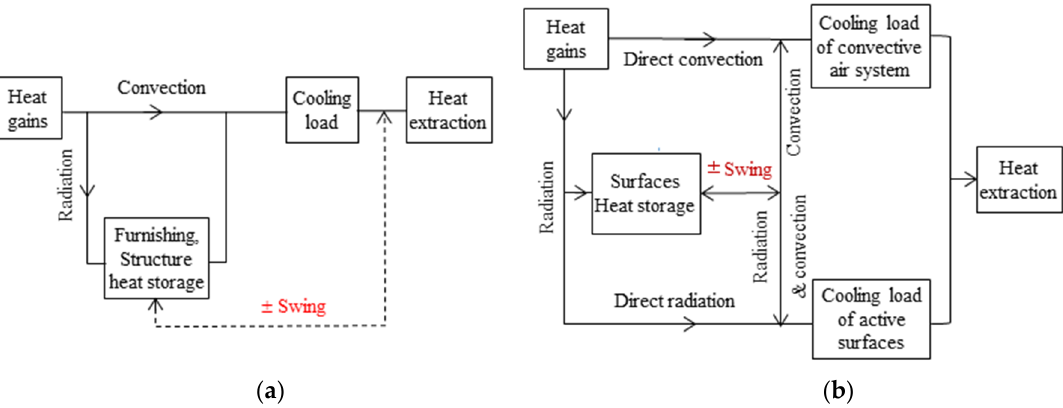
Figure 1. Cooling load generation schemes for ( a ) a convective air system [41] and ( b ) for a combined system (fresh air system + radiant cooling system) [35].